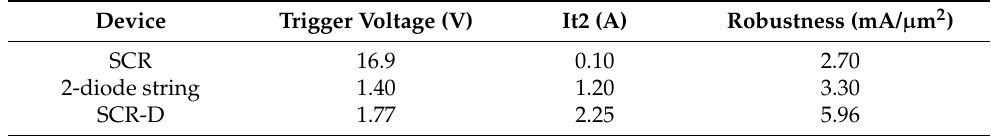
Figure 3. TLP I ‐ V characteristics and leakage measured from diode string, conventional SCR, and Figure 3. TLP I-V characteristics and leakage measured from diode string, conventional SCR, SCR ‐ D proposed in this work. and SCR-D proposed in this work. Table 1. Comparison of the key parameters of three ESD protection devices. Table 1. Comparison of the key parameters of three ESD protection devices.